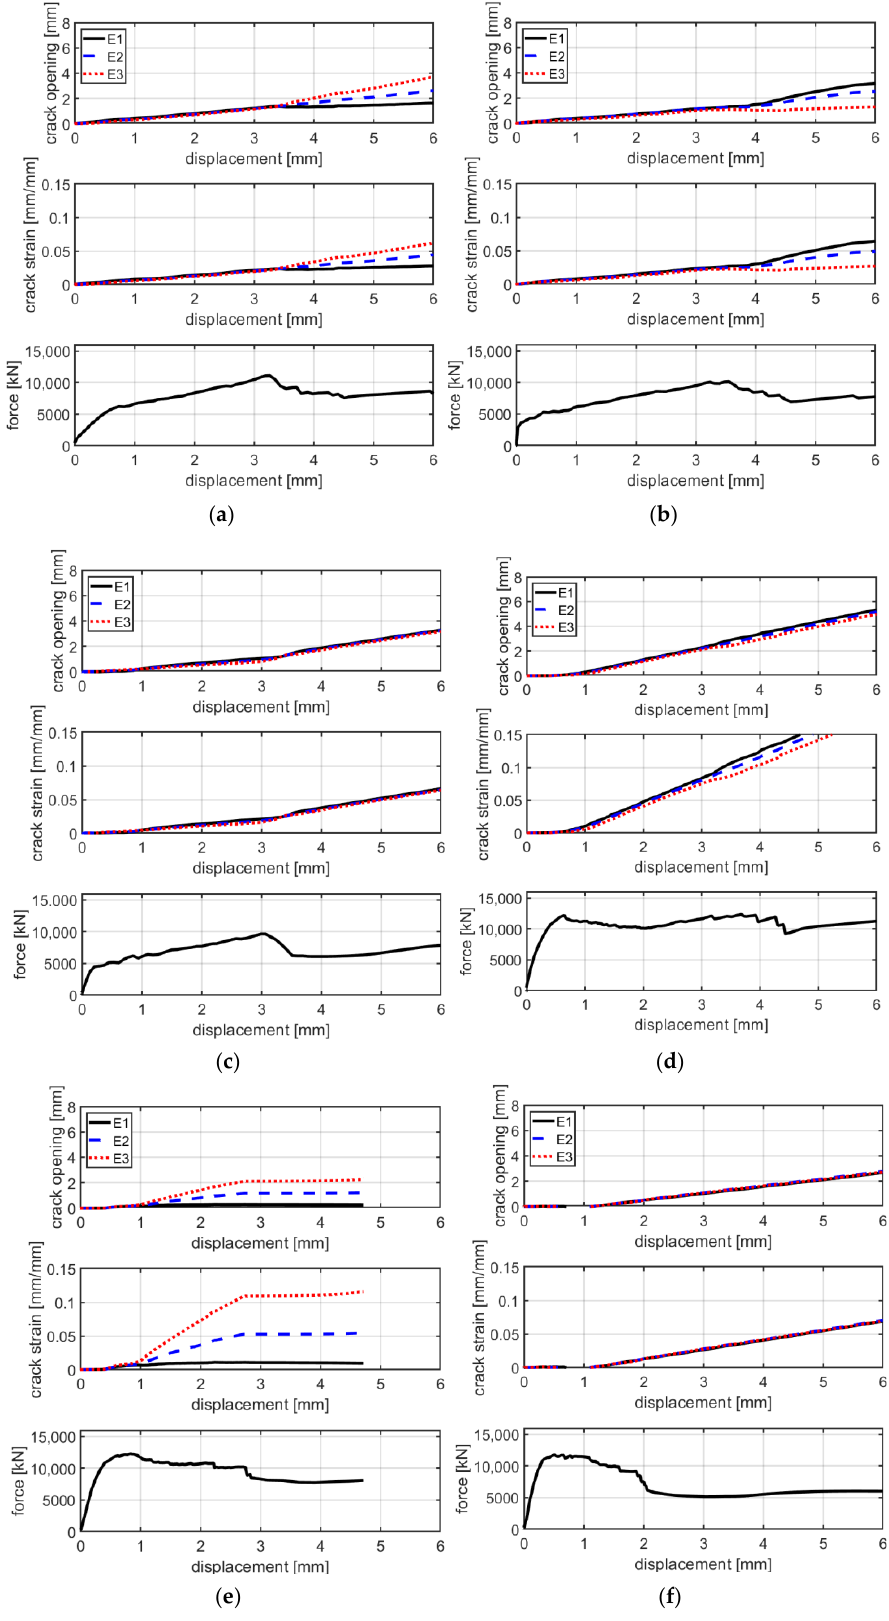
Figure 12. Crack opening/crack deformation/force–displacement curves for specimens CP-1-A ( a ), CP-2-A ( b ), CP-3-A ( c ), CPf-1-A ( d ), CPI-A ( e ) and CPf-3-A ( f ). The mode of failure of C-F/TRC specimens is governed by the pull-out of the textile fabric from the cementitious matrix; however, the shape of the force – displacement curve slightly differs from that of the C-TRC specimens in the first and second stage. As shown in Figure 10, the maximum load is generally reached in the first stage, while the second branch is descendant. The average maximum load is 12,159 N. In close proximity to the maximum load, a first transversal crack appears, whereas the stiffness is reducing. This event leads to the second stage, which is characterized by a decrease in the load and a progressive propagation of transversal cracks along the specimen. The propagation of transversal cracks along the specimen is shown in Figure 13. In this phase, the presence of the short steel fibers affects the performance of the layer by reaching higher loads in the various stages and by distributing stresses along the specimens through the effect of the short fibers. In the third stage, the drop in load also constitutes a quick widening of the crack, leading to the last part of the graph: an almost linear behavior in which the load slightly increases due to the friction between the rovings of the textile fabric and the